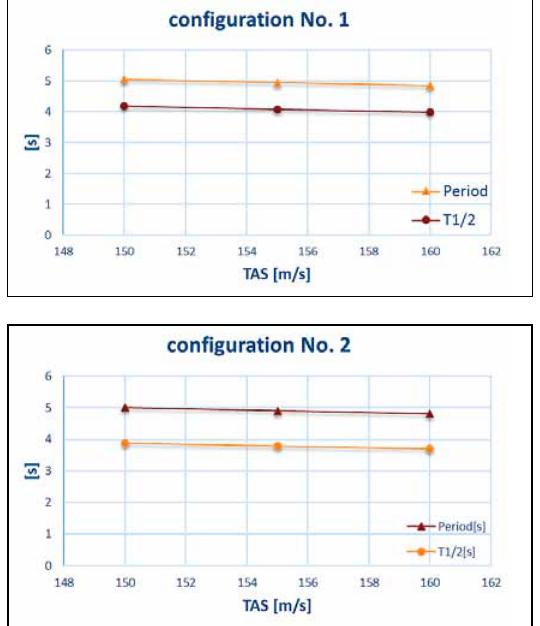
Fig. 15. The period and time to half damping for the dutch roll